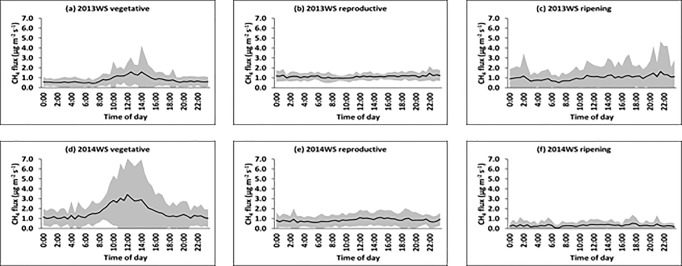
a,b,c,d,e,f. Mean diel patterns of CH4 flux during the different growth periods of the rice plant (vegetative, reproductive, and ripening) in the wet seasons (WS) of 2013 (a,b,c) and 2014 (d,e,f). The solid line represents the mean of all days at a given time of day (in 30 min intervals) and the shaded area represents the standard deviation.